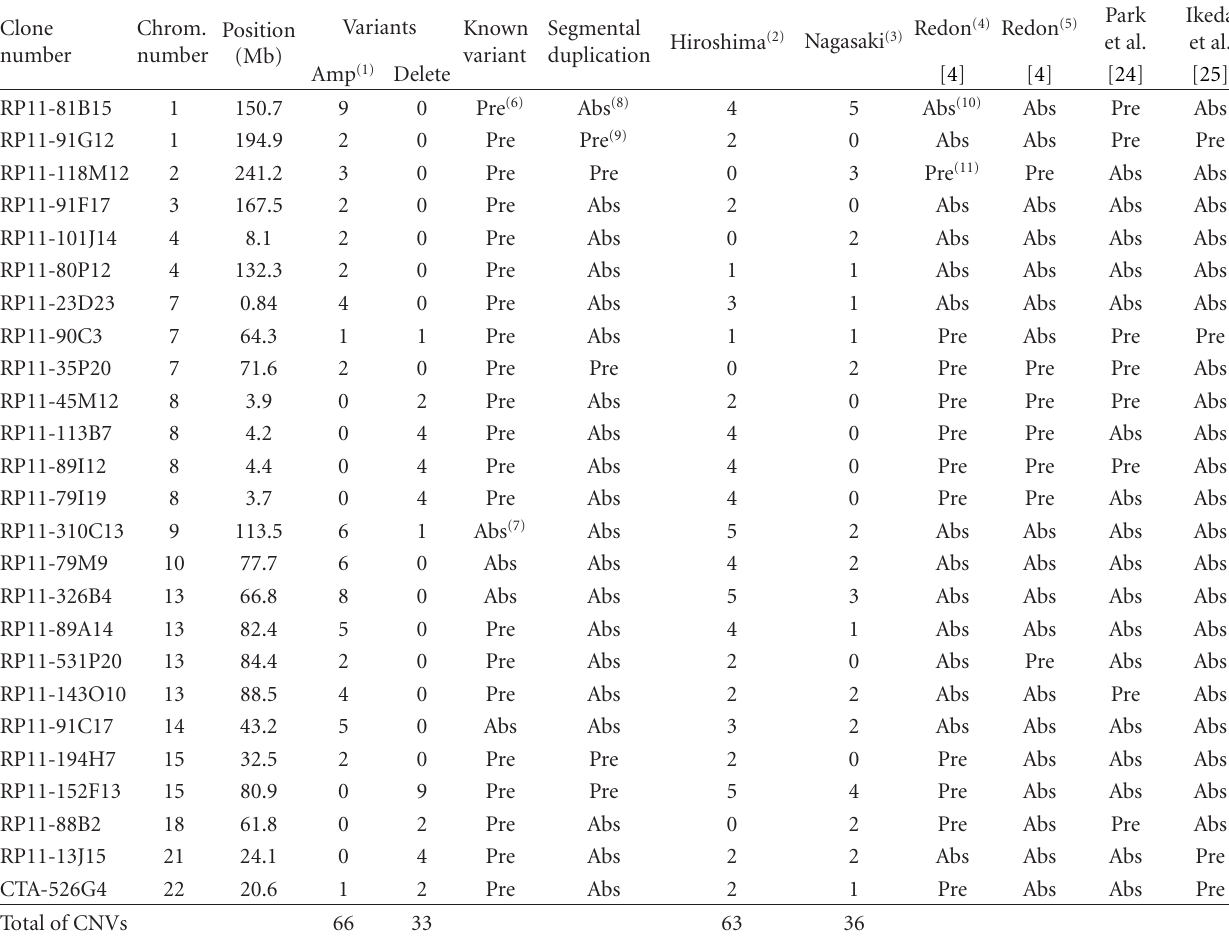
Table 1: Summary of the CNVs detected in plural unrelated